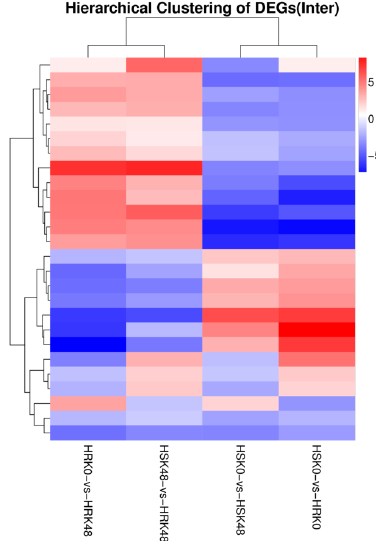
Figure 2. Hierarchical clustering of differentially expressed miRNAs. Note: x -axis represents comparing, y -axis represents differentially expressed miRNAs. Coloring indicates fold change (upregulated: red, downregulated: blue).